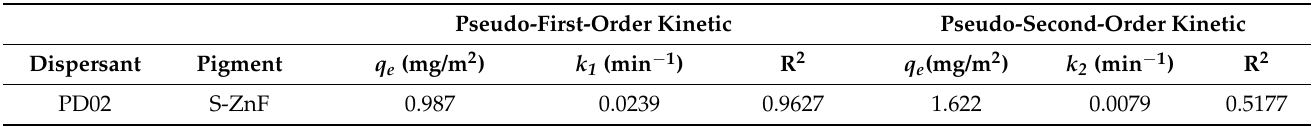
Figure 11. At different adsorption times: ( a ) the adsorption isotherms of dispersants PD02 adsorbed on the S-ZnF particles surface; ( b ) fitting diagram of pseudo-first-order adsorption kinetics model; ( c ) fitting diagram of pseudo-second-order adsorption kinetics model; and ( d ) fitting diagram of Elovich model for dispersants PD02 adsorbed on the surface of the S-ZnF particles. Table 6. The pseudo-first-order kinetic parameters and pseudo-second-order kinetic parameters for dispersant PD02 adsorbed on the surface of the S-ZnF